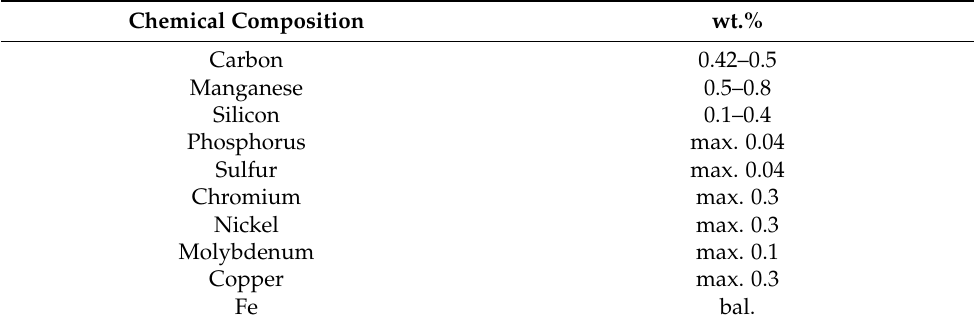
Table 1. Chemical composition of the C45 steel, being the base material in the current study.